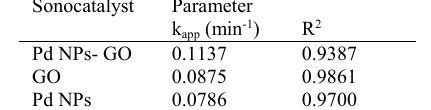
Table 1 the kinetic parameters of degradation of IBF by sonocatalysts. Table 1. the kinetic parameters of degradation of IBF by